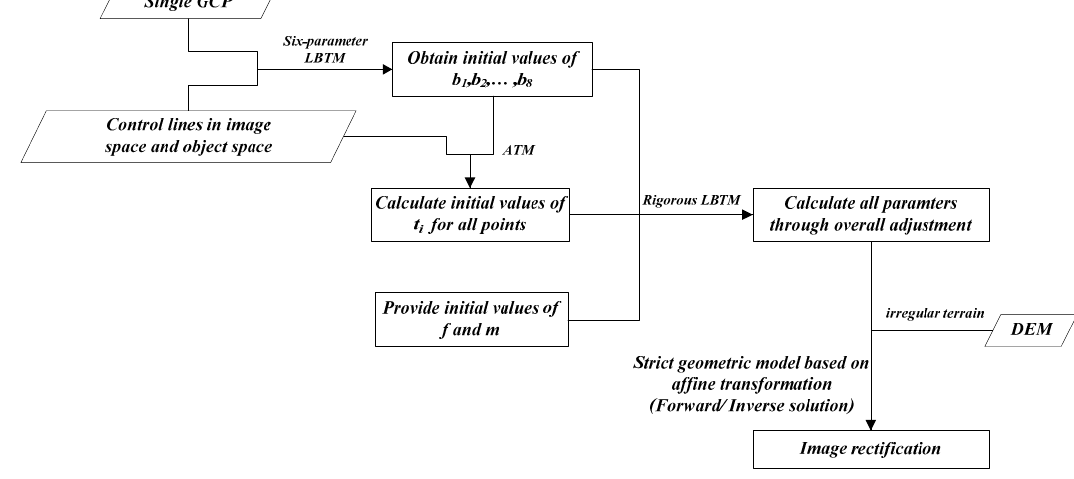
Figure 3. Flow chart of image rectification based on rigorous LBTM.